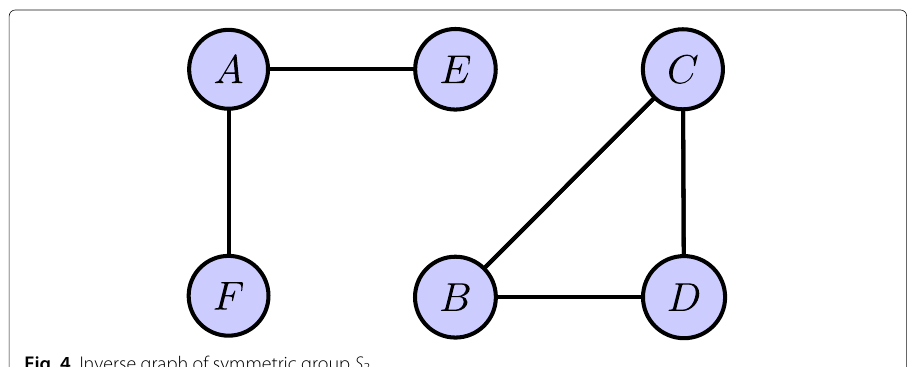
Fig. 4 Inverse graph of symmetric group S